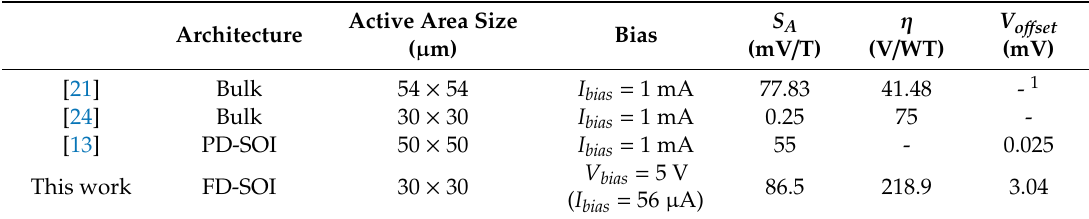
Table 1. Simulated Hall sensor performance summary and comparison.